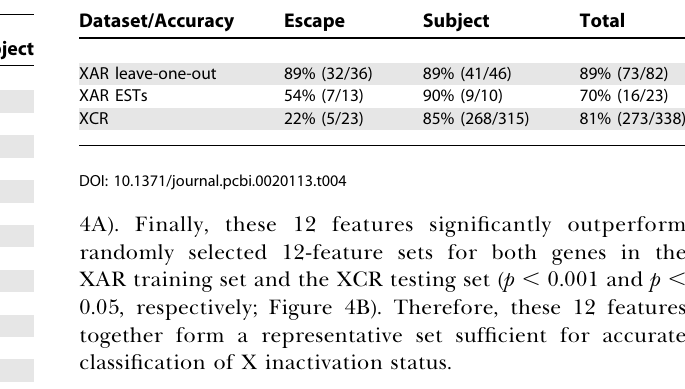
Table 4. Classification Accuracy for XAR Genes, XAR ESTs, and XCR Genes Using a Reduced Set of 12 Features and XAR